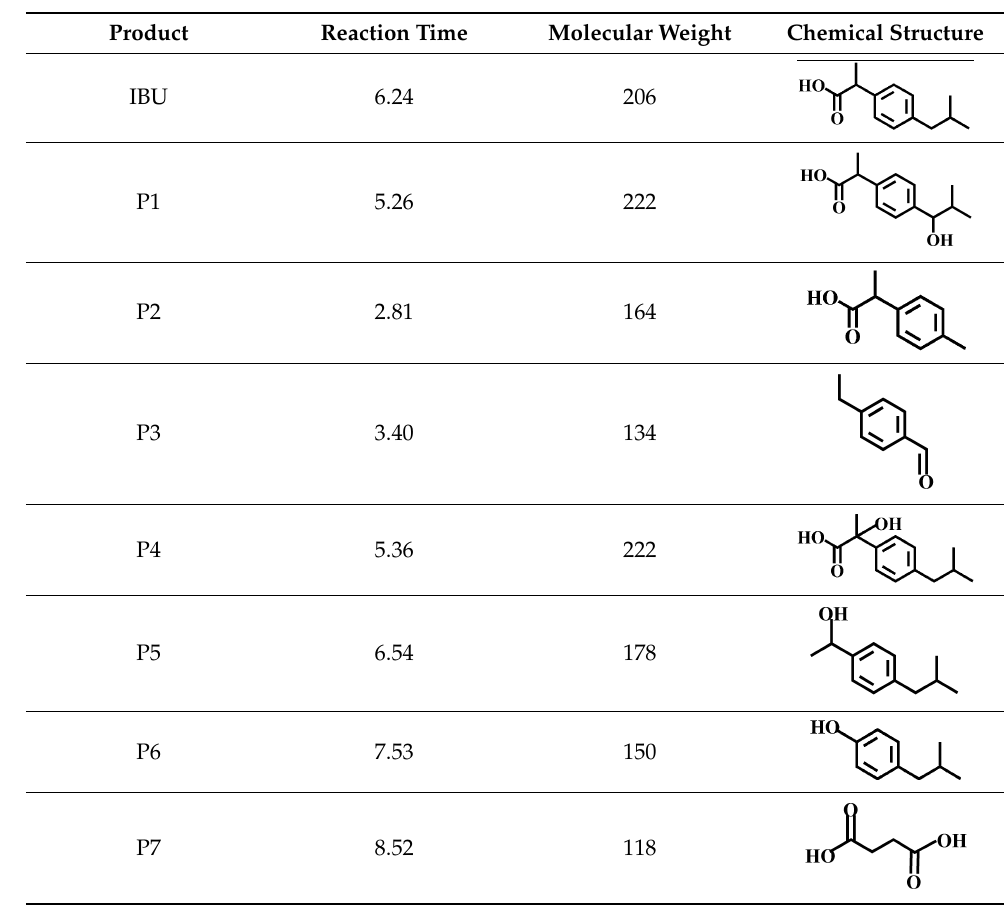
Figure 5. Reaction mechanism of the EC/Fe 3+ /PDS system .